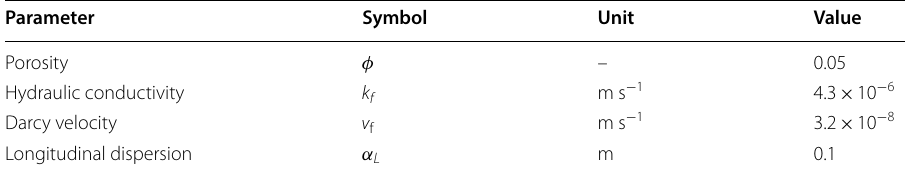
Table 9 Site-specific input parameter used for the model comparison between Mathcad ® and MIN3P